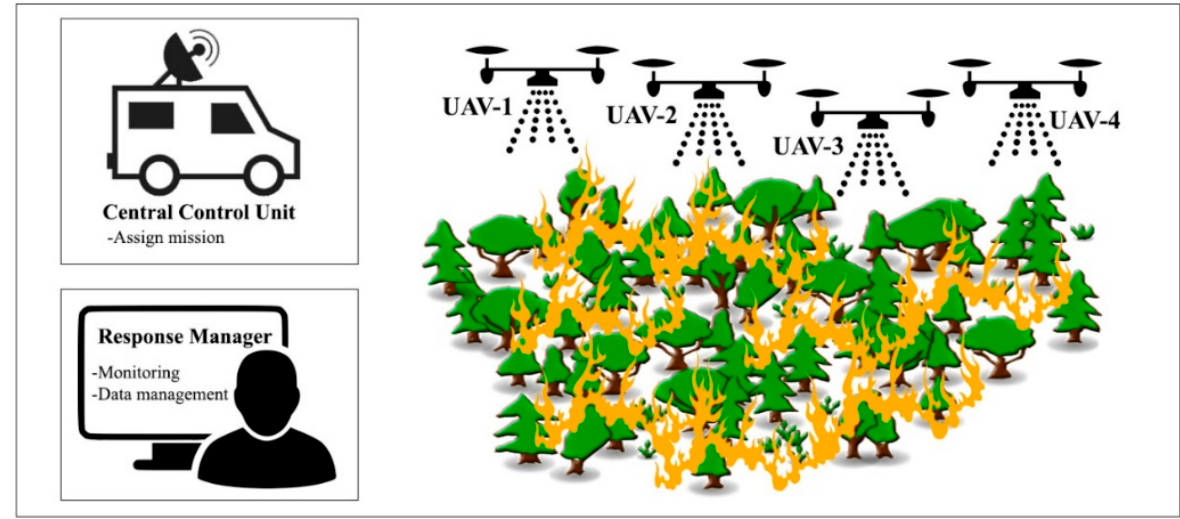
Figure 4. Bushfire monitoring and management through a central control unit using UAVs. UAV swarm systems are assigned to different regions affected by bushfires during post ‐ disaster relief operations and can be used for disaster impact analysis, as shown in Figure 5. The monitoring of UAVs is carried out through the control center remotely. UAV communicates with each other based on the designed algorithm and communication from the control center and responds to changing conditions. Each UAV adopts the specific path assigned for maximum area coverage and captures the disaster region’s images. UAV detects and stores individual knowledge and returns it to the control unit or depot, where the knowledge is combined from all the UAVs. This is used to analyze the damage, highlight optimized UAV routes to and from the depot, and map burnt area. The initial assessment by the UAV swarm will give the direction for the disaster response planning. The images will help rescue stranded people find the safest and shortest routes to access the areas for providing relief services. In addition, the survivors can be detected via image analysis, where the rescue team can establish contact with the survivors and perform quick rescue operations. The UAVs have been employed in the United States to provide relief services through enhanced imagery over fire areas [64]. Figure 5. UAV swarm capturing affected region and knowledge sharing mechanism.